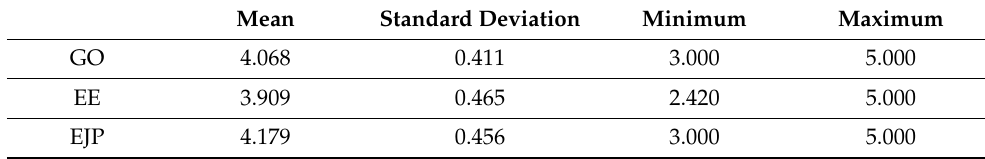
Table 1. Descriptive Analysis.